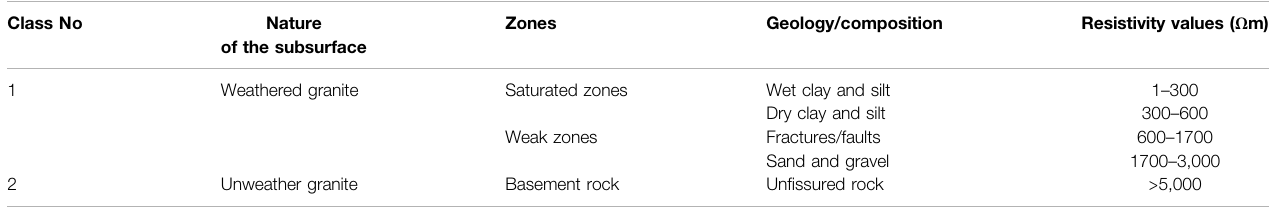
TABLE 6 | Classi fi cation of ERT-inverted models on the scale of resistivity values into